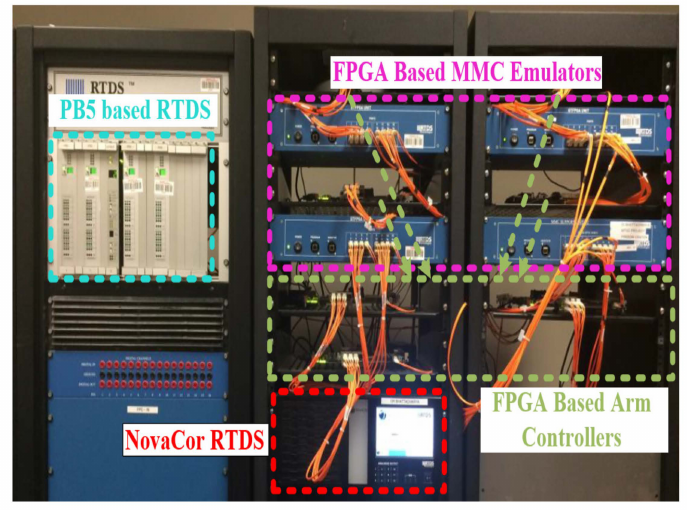
Figure 10. CHIL implementation set-up for MTDC